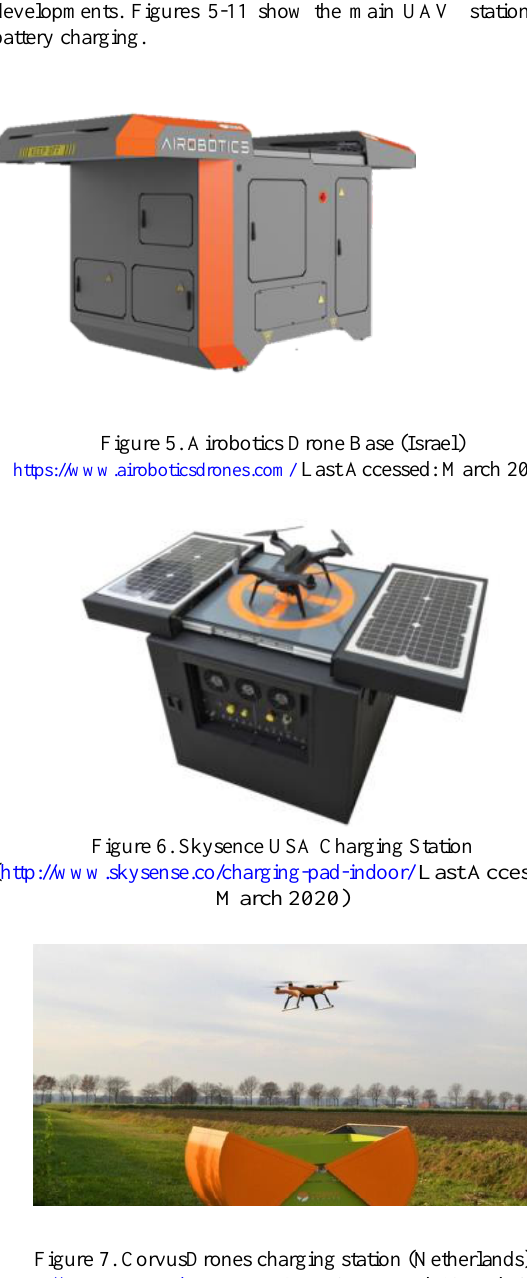
Figure 3. Stationary complex - Installed on a car trailer, trunk. The UAV lands in the box.